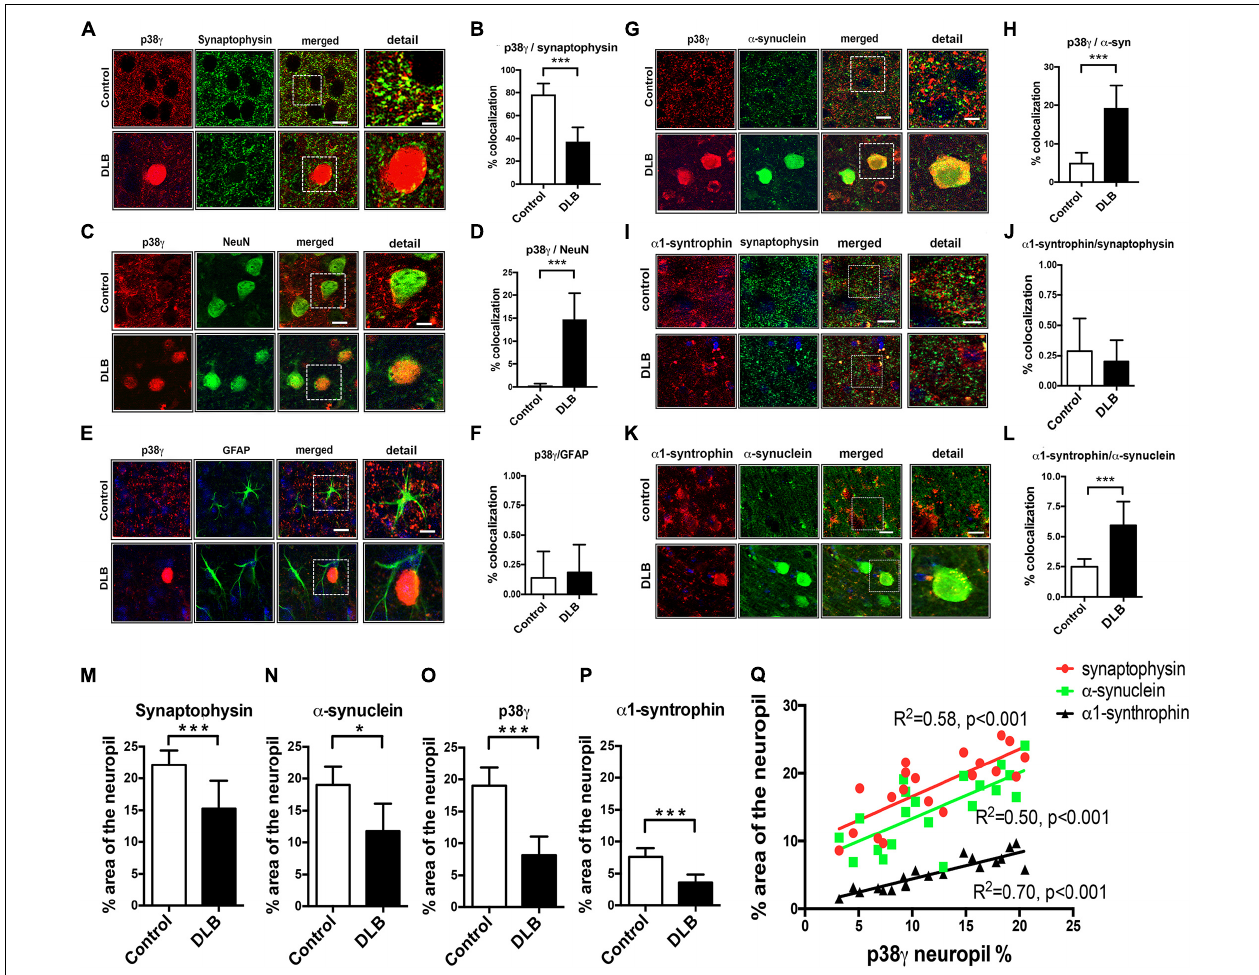
FIGURE 2 | Double immunohistochemical analysis of p38 γ cellular localization in DLB and control brains. Vibratome sections from the frontal cortex of human control and DLB cases were double immunofluorescence labeled with antibodies against p38 γ (red) and neuronal and glial cell markers (green) and analyzed with Apotome II mounted in a Carl Zeiss AxioImager Z1 microscope. Far right (detail): enlarged image of the area contained in the dotted square. (A) p38 γ (red) and the pre-synaptic marker synaptophysin (green), colocalization in yellow; (B) image analysis showing high colocalization of p38 γ to synapses; (C) p38 γ (red) and the neuronal marker NeuN (green); (D) image analysis showing increased localization of p38 γ to neurons in DLB; (E) p38 γ (red) and the astroglial cell marker GFAP (green); (F) image analysis showing minimal localization of p38 γ to astroglia in human brains; (G) p38 γ (red) and α -synuclein (green); (H) image analysis showing high colocalization of p38 γ to Lewy bodies in DLB cases; (I) α 1-syntrophin (red) and the pre-synaptic marker synaptophysin (green), colocalization in yellow; (J) image analysis showing low colocalization of α 1-syntrophin to pre-synaptic site in control and DLB cases; (K) α 1-syntrophin (red) and α -synuclein (green); (L) image analysis showing high localization of α 1-syntrophin and α -syn in DLB. Scale bars are 10 µ m in the standard panels and 5 µ m in the zoomed panels. Image analysis represents% colocalization between the two markers. n = 8 for control and n = 12 for DLB (*** p < 0.001). Image analysis of p38 γ and synaptic proteins in DLB and control brains. The single labeled channels from above were further analyzed to calculate the percent area of the neuropil occupied by (M) synaptophysin; (N) α -syn; (O) p38 γ ; and (P) α 1-syntrophin fluorescence in healthy control and DLB patients. (Q) Linear regression analysis was performed to ascertain the correlation coefficient between the levels of p38 γ in the neuropil (% area) and synaptophysin, α -syn, and α 1-syntrophin in control and DLB cases. n = 8 for control and n = 12 for DLB (* p < 0.05, *** p <